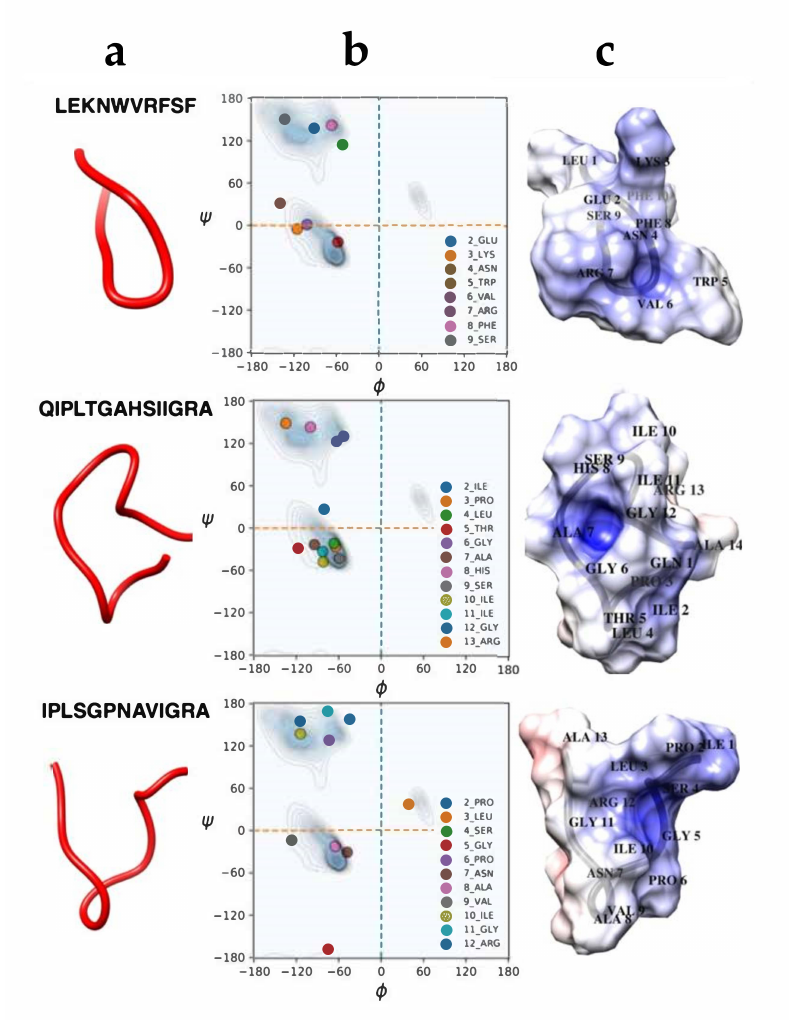
Figure 2. ( a ) Most representative equilibrium structures of peptides #6, #11 and #12, obtained by MD simulations. ( b ) Ramachandran plots showing the values of the psi ( Ψ ) and phi ( Φ ) angles assumed by each residue, as indicated. ( c ) Electrostatic potential of the peptides, shown as surfaces; red, blue and white colors are used for negative ( − 3 kT / e), positive ( + 7 kT / e), and zero values,